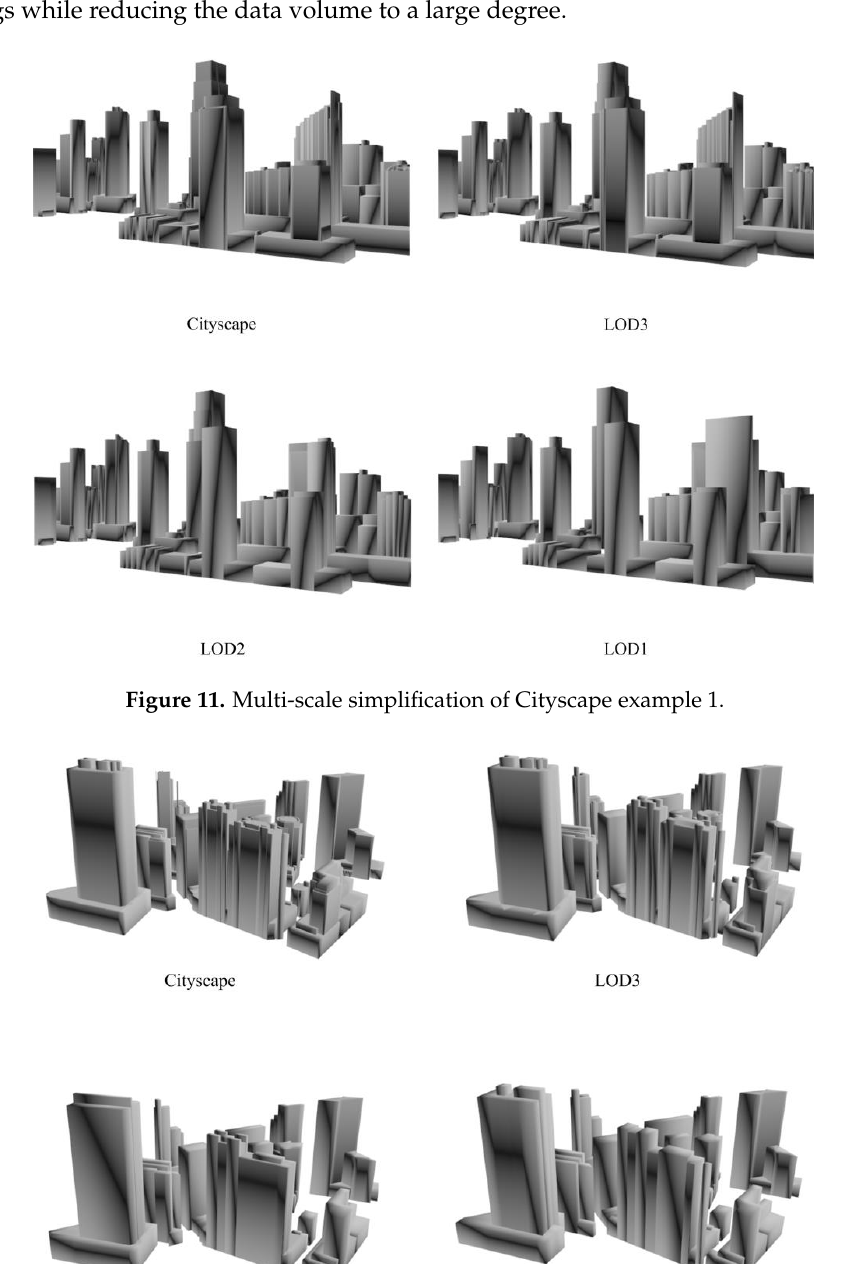
Table 2. Data volume reduction for multi-scale simplification of the cityscape.